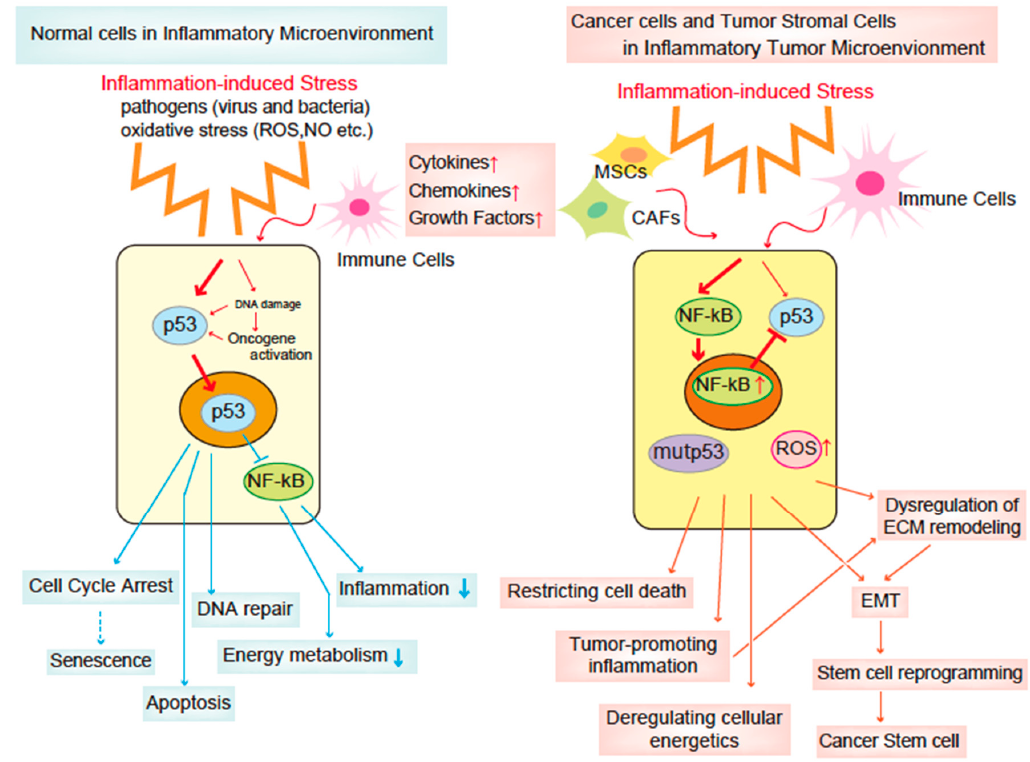
Figure 1. Role and regulatory mechanism of p53 in the inflammatory tumor microenvironment. p53 is regulated by inflammation and inhibits the generation and maintenance of cancer stem cells